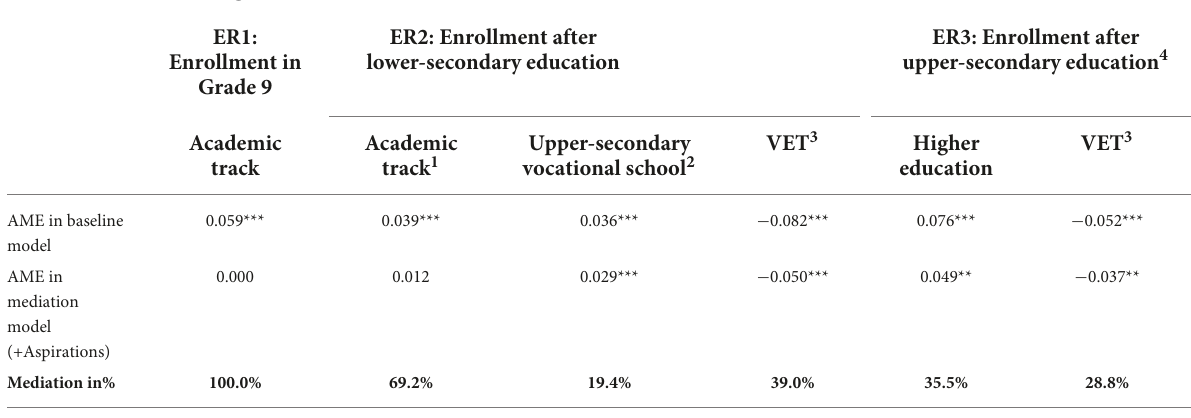
TABLE 1 Mediation of immigrants’ differences in enrollment